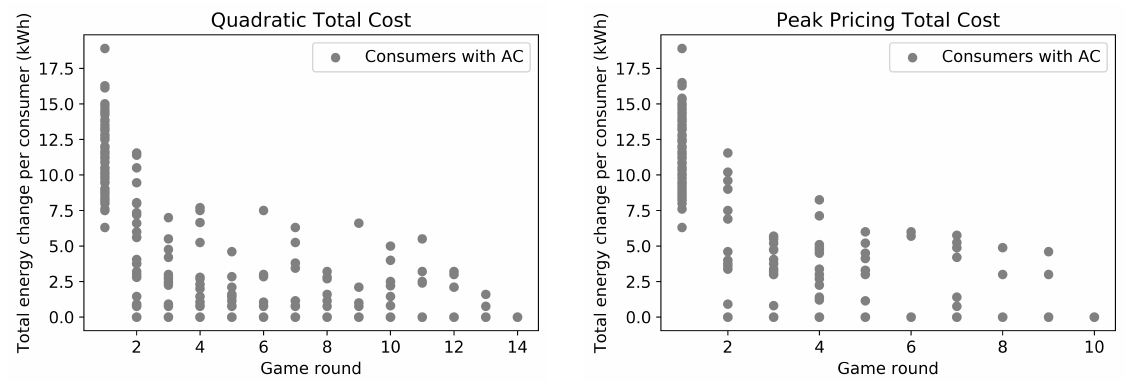
Figure 7. Convergence of the Best Response